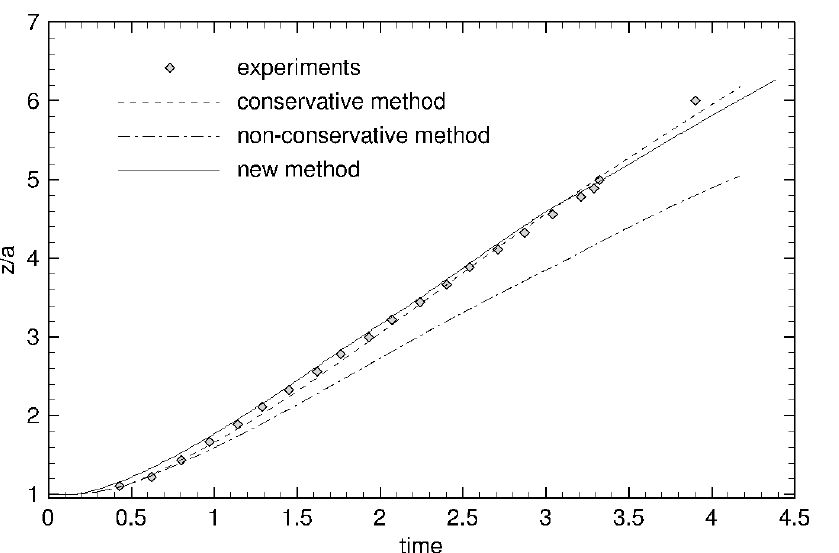
Figure 7. Evolution of the front of propagation: comparison between experimental data and several numerical methods: the Ghost Fluid method (non-conservative method), the conservative method of Raessi and Pitsch and our new method, The dimensionless location of the front z is plotted as a a (cid:112) g / H function of the dimensionless time T = t